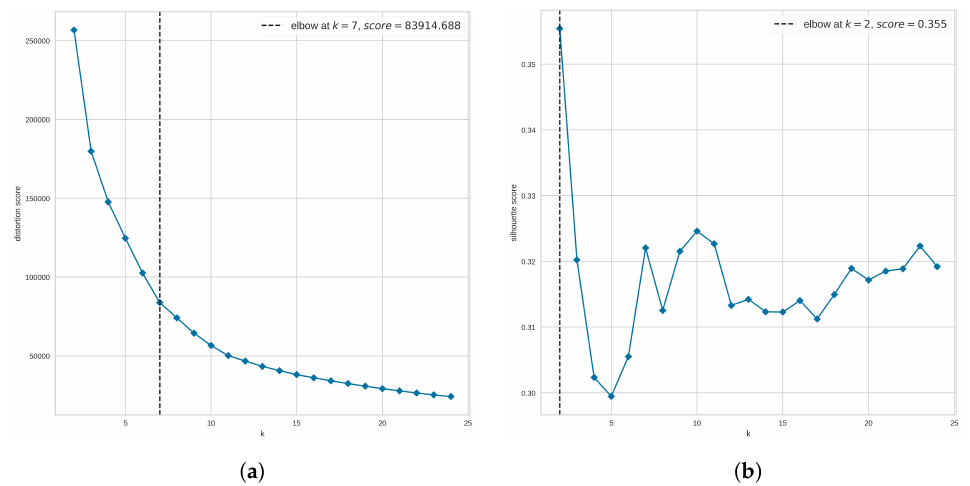
Figure 8. Elbow method to narrow the search for the optimal number of clusters when using UMAP clustering. In the second step of the hyperparameter tuning process for UMAP clustering, the elbow method was explored, covering a range of clusters from 2 to 25, and using ( a ) the distortion metric and ( b ) the silhouette metric. For each plot, the horizontal axis shows the number of clusters ( k ) evaluated, and the vertical axis shows the corresponding